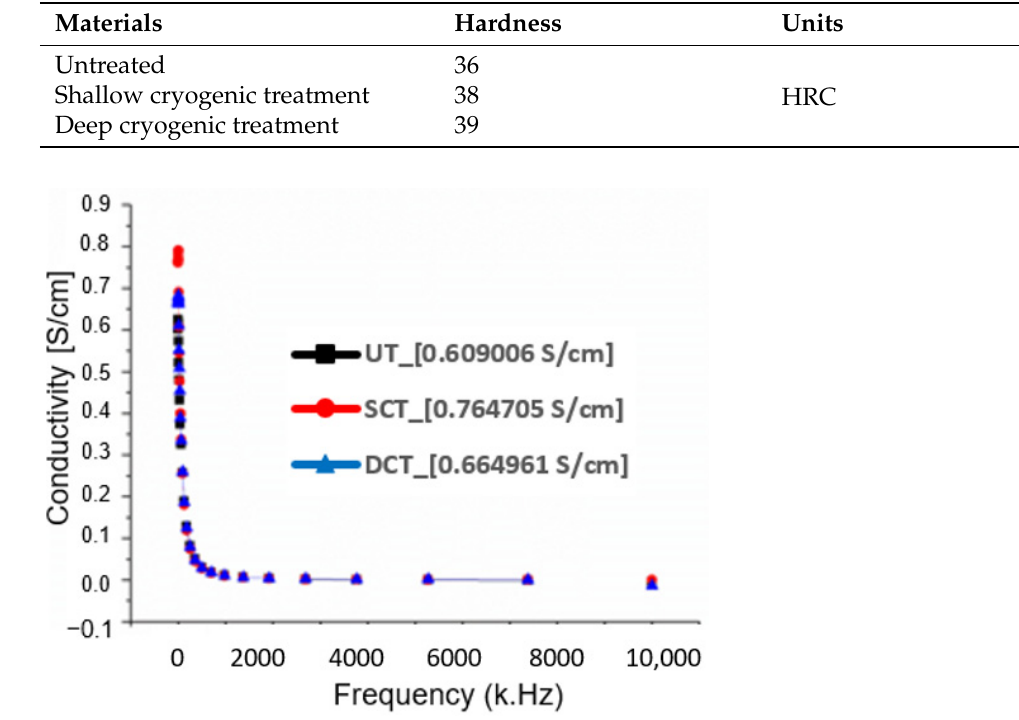
Figure 2. Electrical conductivity of UT (untreated), SCT (shallow cryogenically treated) and DCT (deep cryogenically treated) samples.